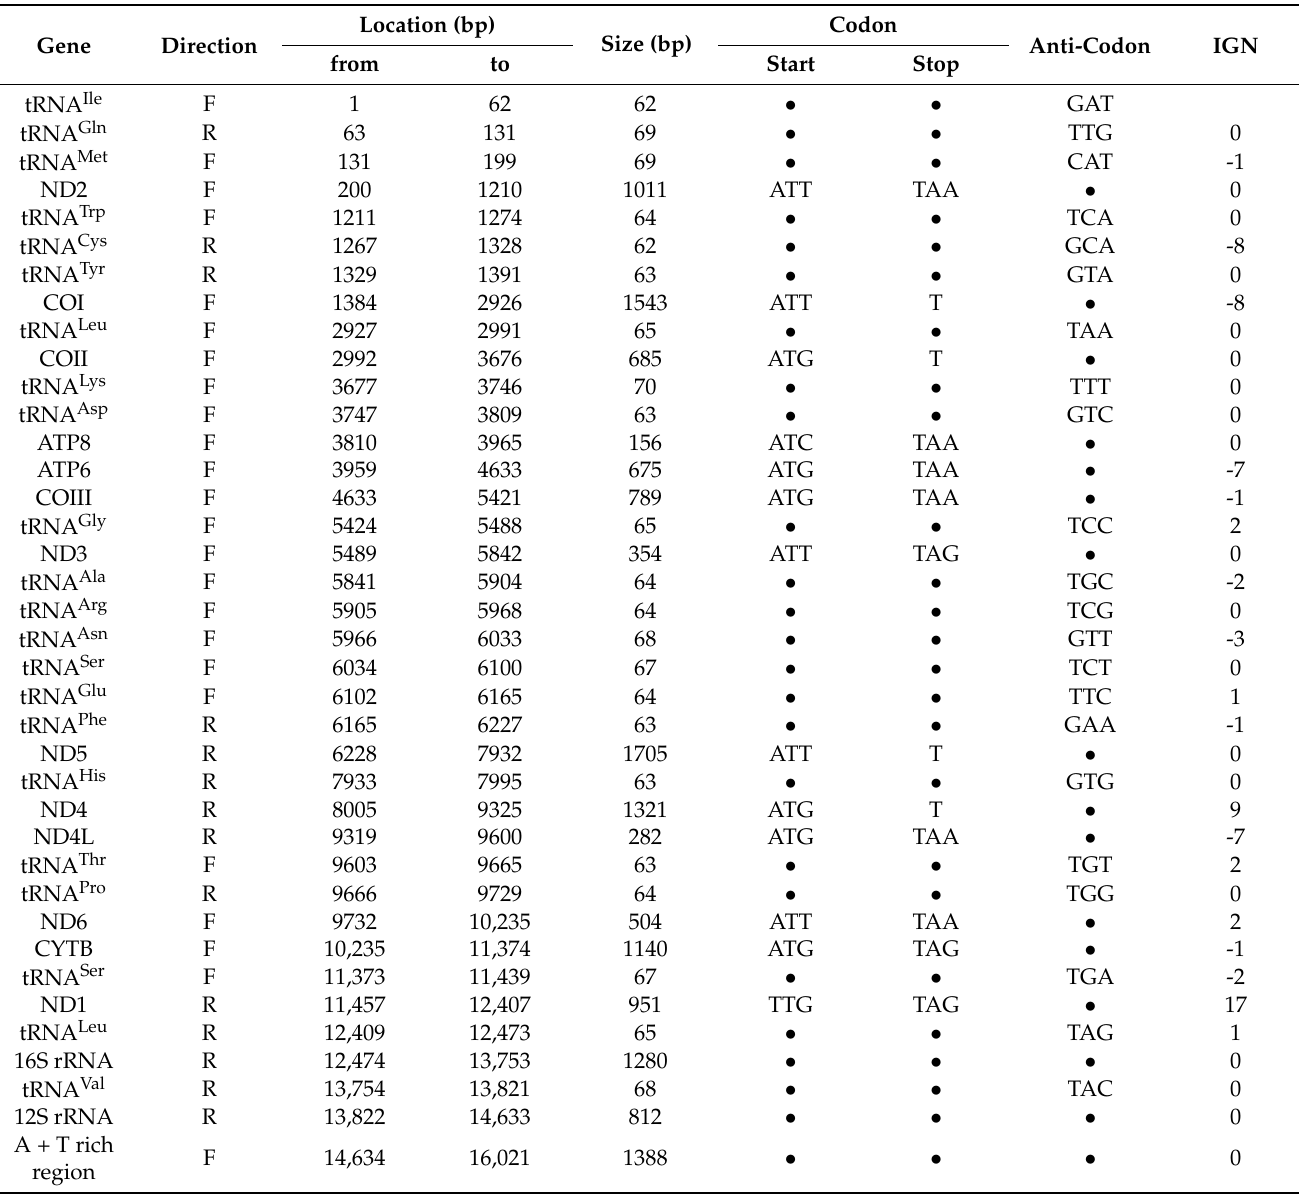
Table 2. Organization of the Luperomorpha xanthodera mitochondrial genome. IGN: intergenic nu- cleotides. Negative values refer to overlapping nucleotides. dots ( • ) indicate no value, hyphens (-) represent the size of overlapping